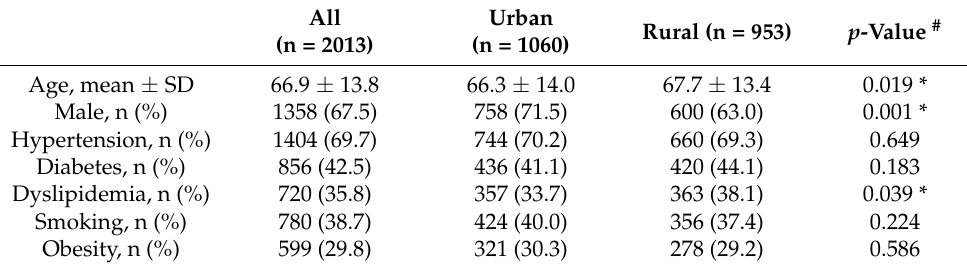
Table 1. Distribution of conventional risk factors for urban and rural areas.